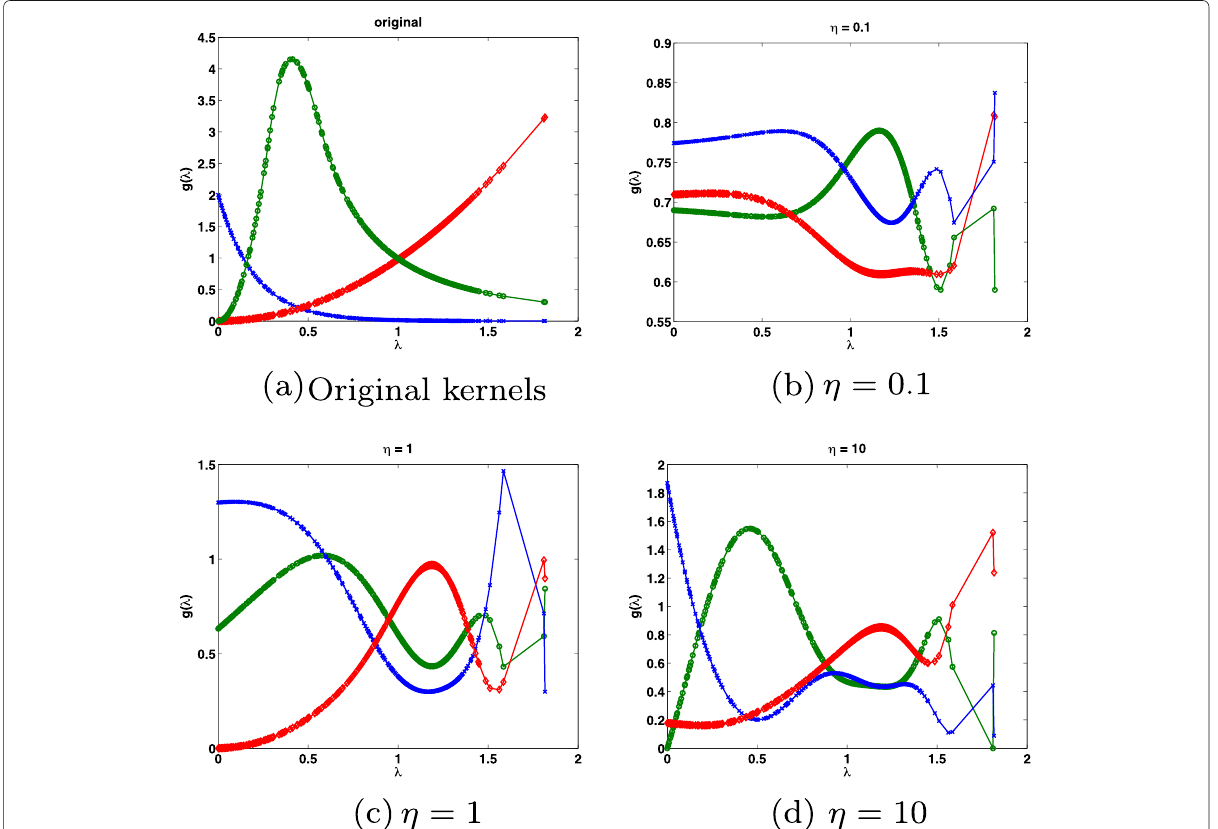
Fig. 2 Illustration of the kernels recovered for different values of η in the dictionary learning problem. ( a ) Original kernels. ( b ) η =0.1. c η = 1. ( d ) η = 10 settings without rate constraints. We approximate 1000